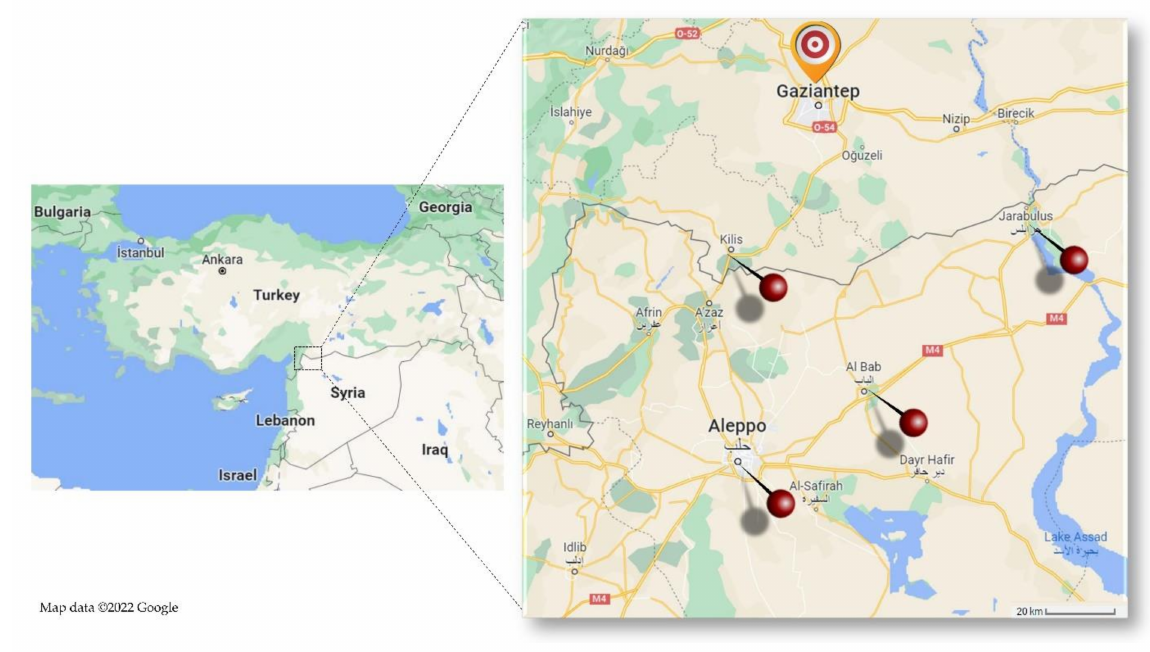
Figure 1. Centers in and outside the country from which the neonates were referred to our hospital in Gaziantep. Google. (n.d.). [Google Maps Gaziantep and Aleppo]. Retrieved from https://goo.gl/ maps/m3td1Yo6xU92fRgg7 (accessed on 5 September